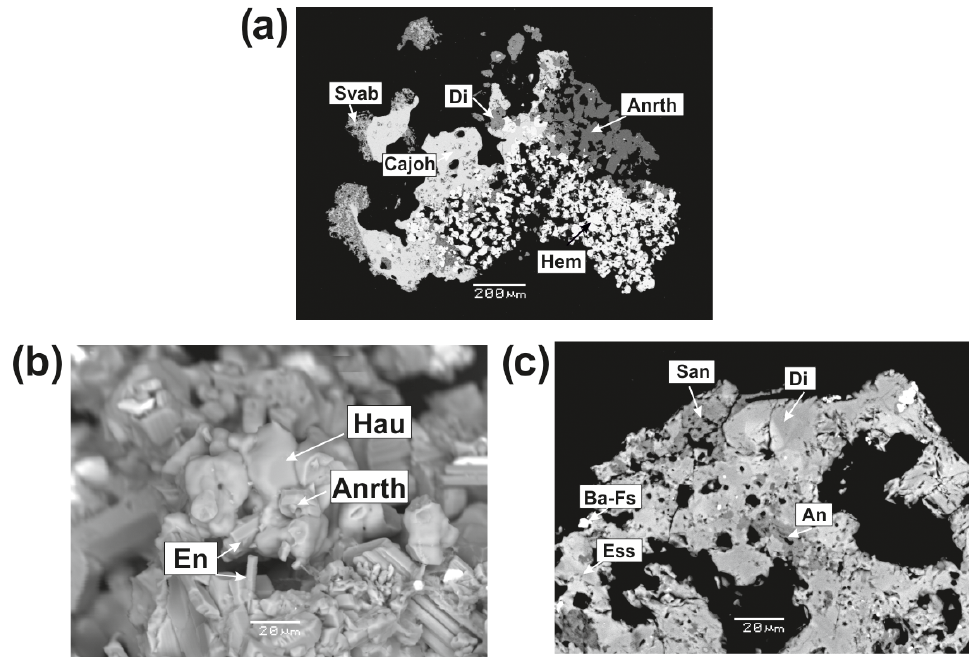
Figure 4. Anorthoclase (Anrth) and barium feldspar from the Arsenatnaya fumarole: aggregate of anorthoclase crystals with hematite (Hem), diopside (Di), svabite (Svab), calciojohillerite (Cajoh) (a) ; aggregate of hauyne crystals with anorthoclase and enstatite (En) (b) ; crust, consisting of diopside (Di) and sanidine (Snd) with inclusions of anorthite (An), esseneite (Ess) and barium feldspar (Ba Fs) (c) . BSE images.